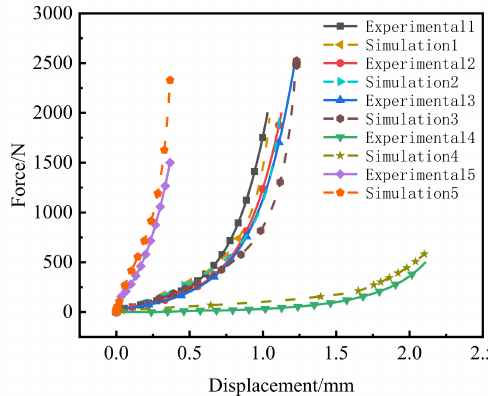
Figure 10. Comparison of the influence of different initial relative densities on molding